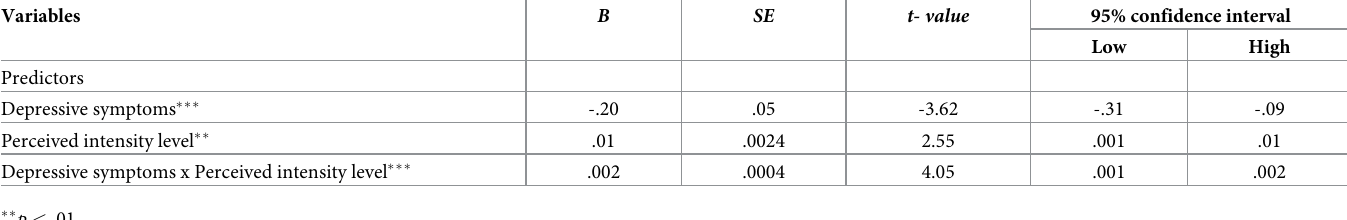
Table 4. Model of the relative effectiveness of reappraisal and distraction (estimated coefficients, standard errors, and 95% confidence intervals for independent and moderator variables in Experiment 2). Variables